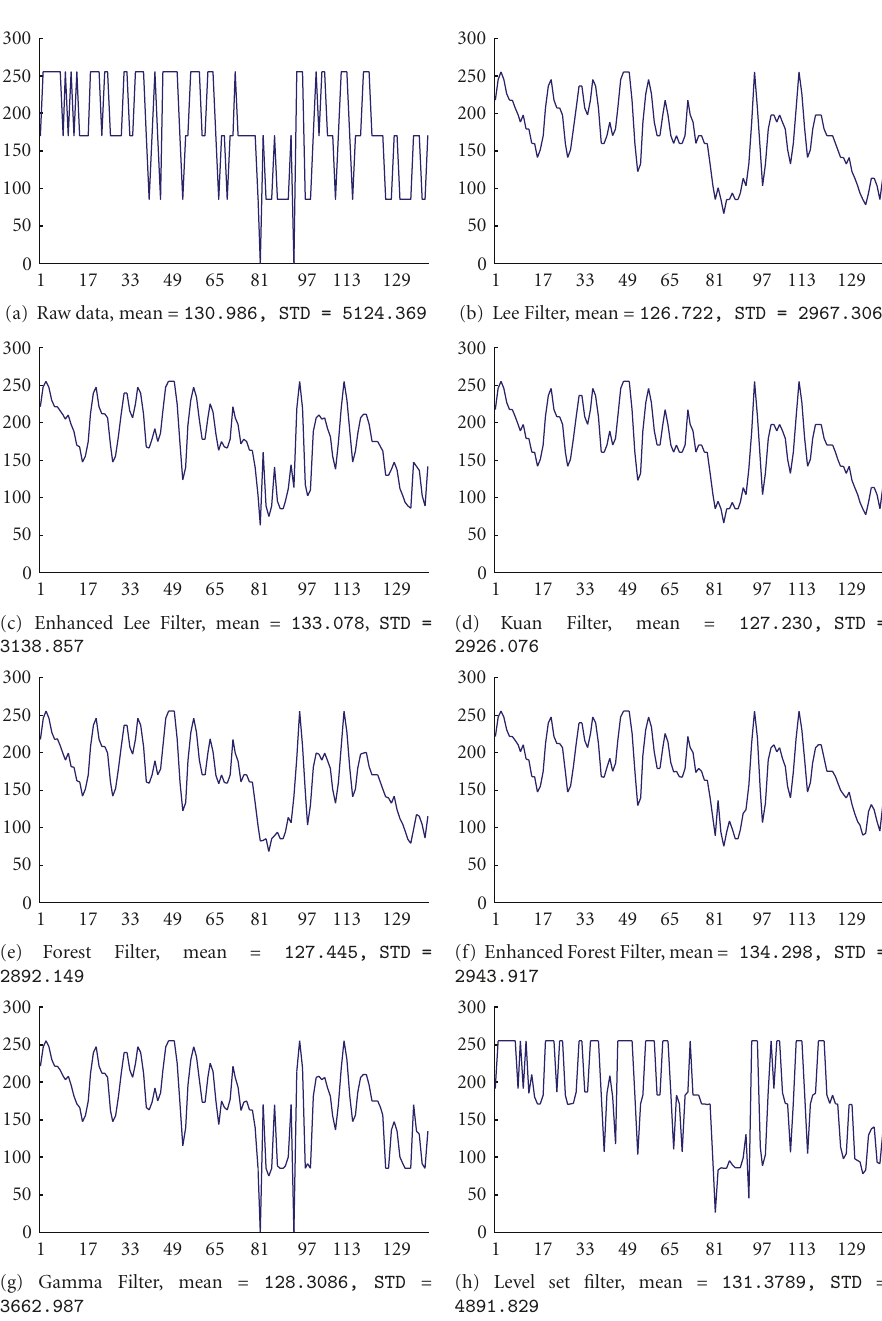
η s . Comparison between the neighborhood average and the threshold is used to select the right speed function to use. Flow under min( κ ,0) would preserve some of the structure of the curve, while flow under max( κ ,0) completely di ff uses away all of the information. This switch